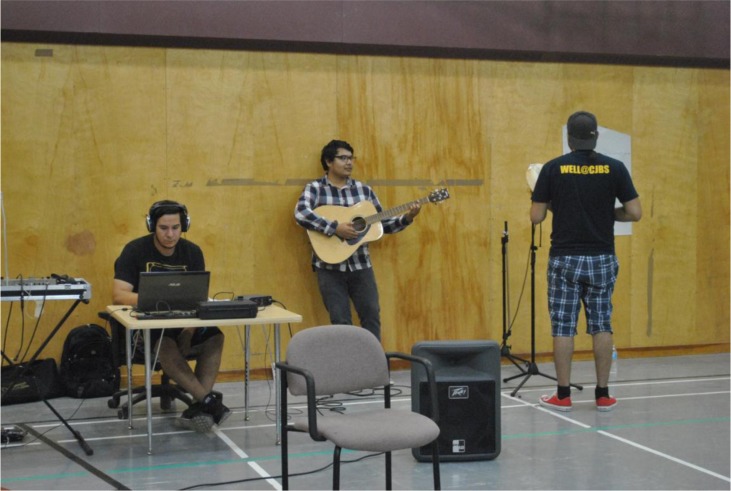
Recording components of the music for “We Write the Future”. Photo credit: Sahar Fanian.